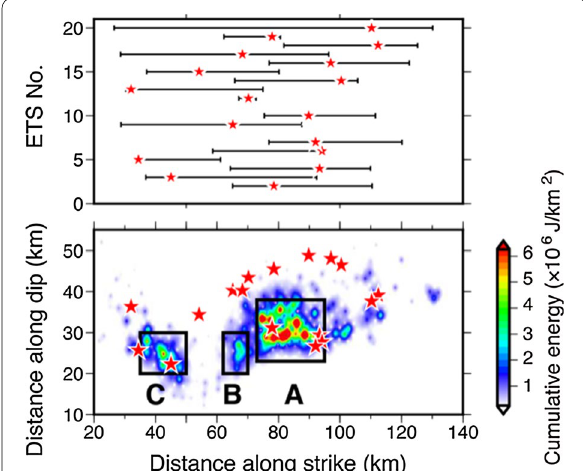
Fig. 6 (upper) Plot showing the rupture extent along the strike direction (black bars) and the start point (red stars) of each ETS event. (bottom) The spatial distribution of cumulative seismic energy release of all ETS events and the start point of each ETS event (red stars). Black rectangles indicate the location of high‑energy